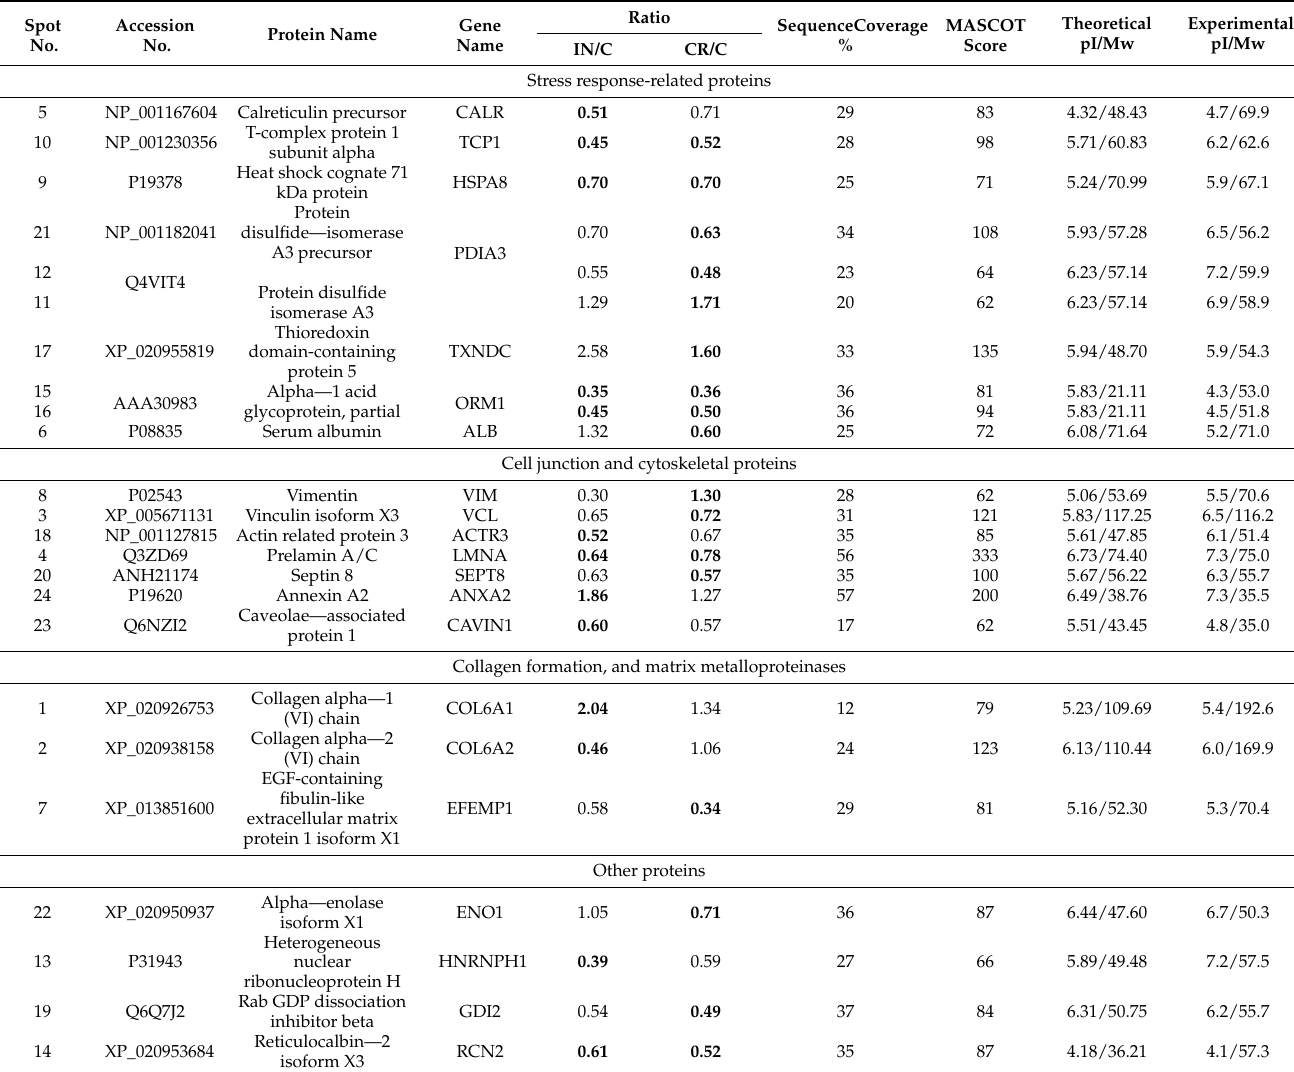
Table 3. List of differentially accumulated protein spots found in the aorta of pigs fed experimental diets (IN,